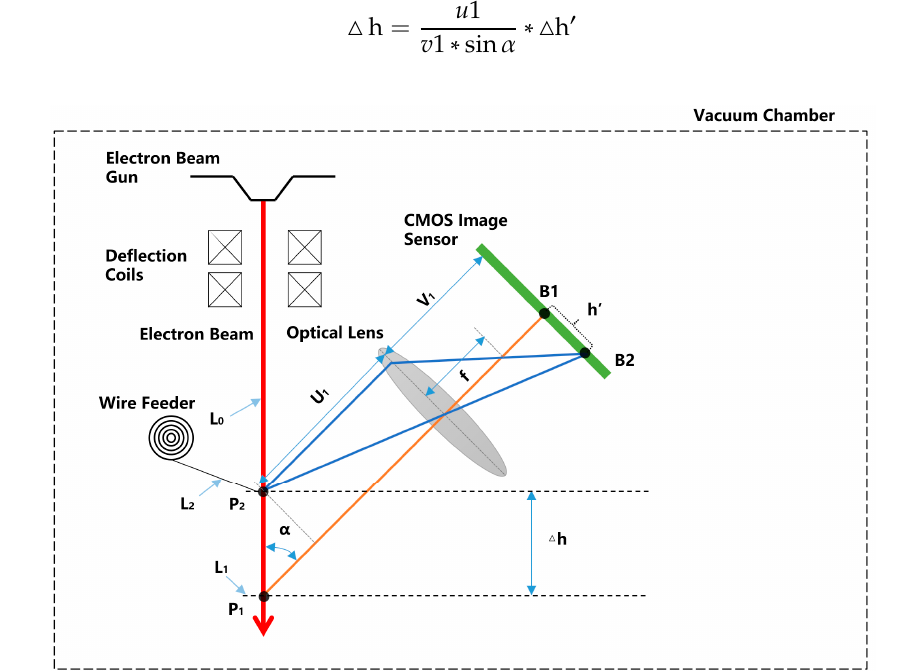
Figure 5. Principle of transformation from pixels to millimeters. Figure 7. Principle of transformation from pixels to